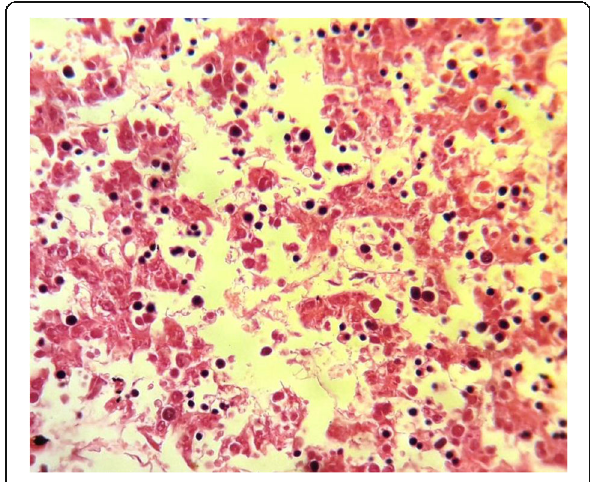
Fig. 6 Photomicrograph from section taken from the liver shows evidence of fetal hematopoiesis